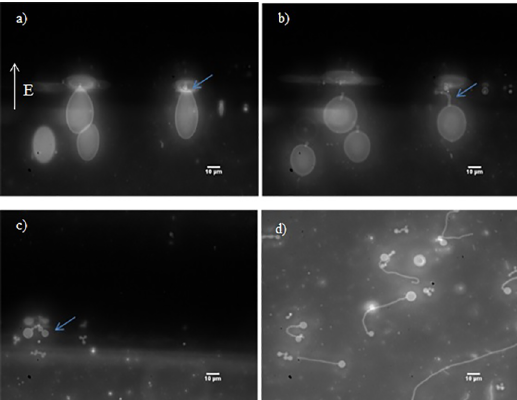
Figure 2. Sequence of optical fluorescence microscopy images of the GUVs produced from DLPC and rhodamine with the application of: (a) and (c) 18 V/mm and 60 Hz; (b) and (d) 4 V/mm and 60 Hz.